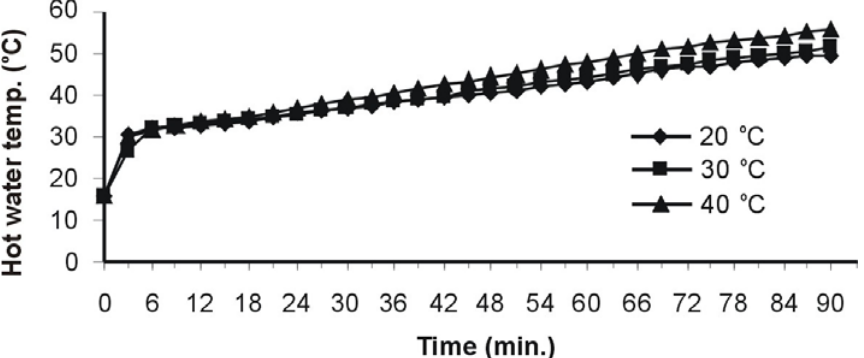
Figure 6. The change in the domestic hot water temperature in the storage tank along the experiment for the circulation pump flow rate CP I.